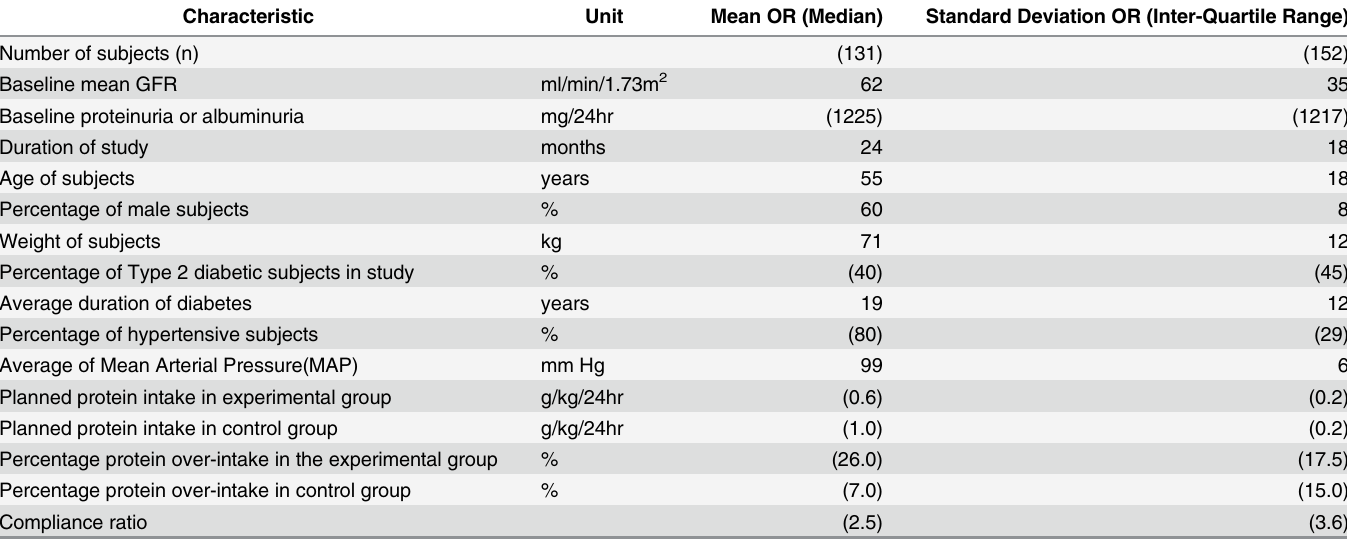
Table 3. Summary of the characteristics of the population pooled from the included